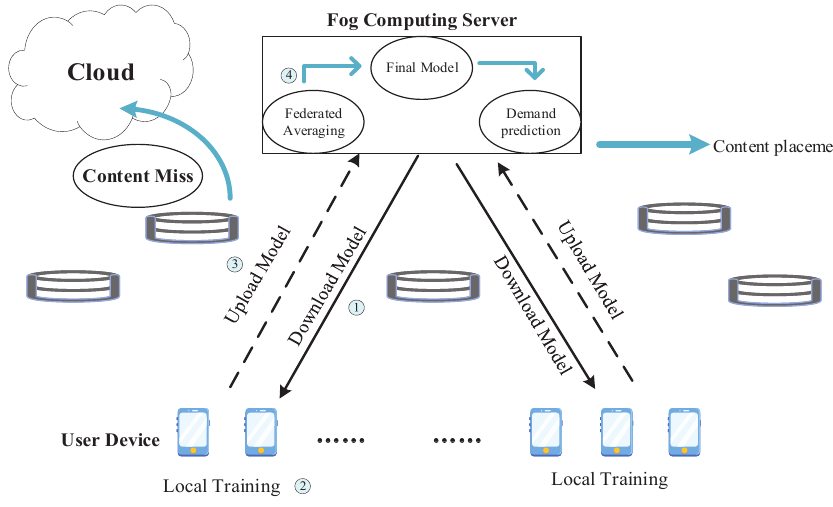
Figure 2. Federal learning prediction